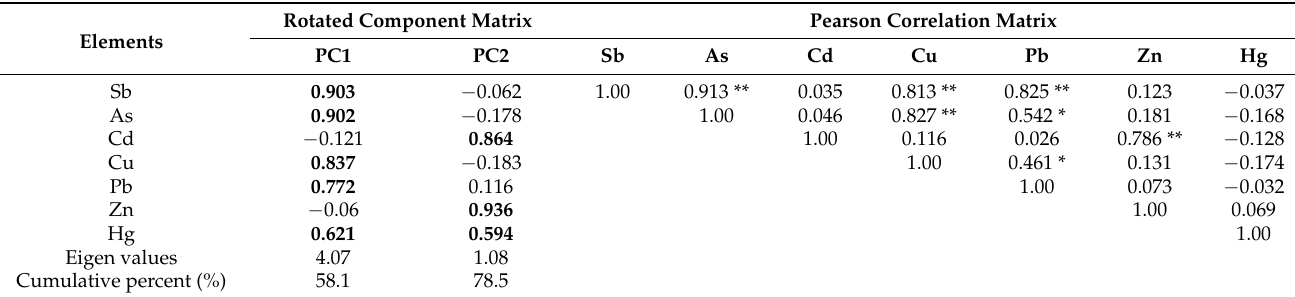
Table 4. Pearson correlation matrix and component matrix for the elements’ concentrations in the surrounding soils. Rotated Component Matrix Pearson Correlation Elements